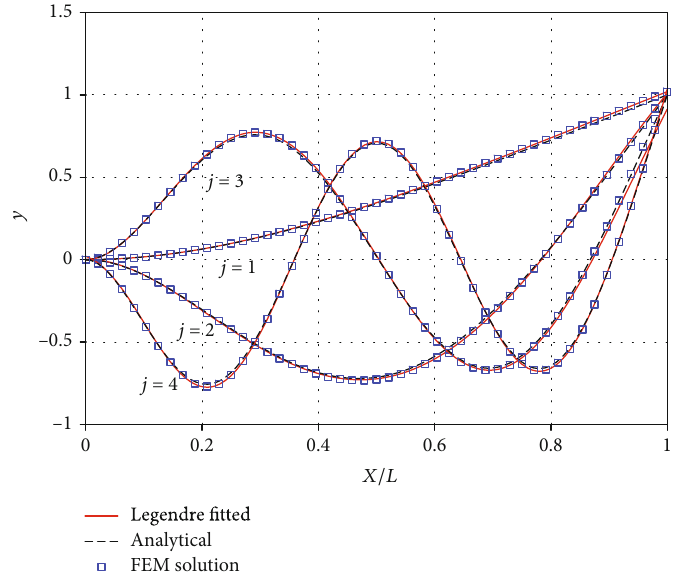
Figure 8: Analytical and fi nite element solutions for the fi rst four modes of a cantilever beam and the fi tted continuous mode shapes.